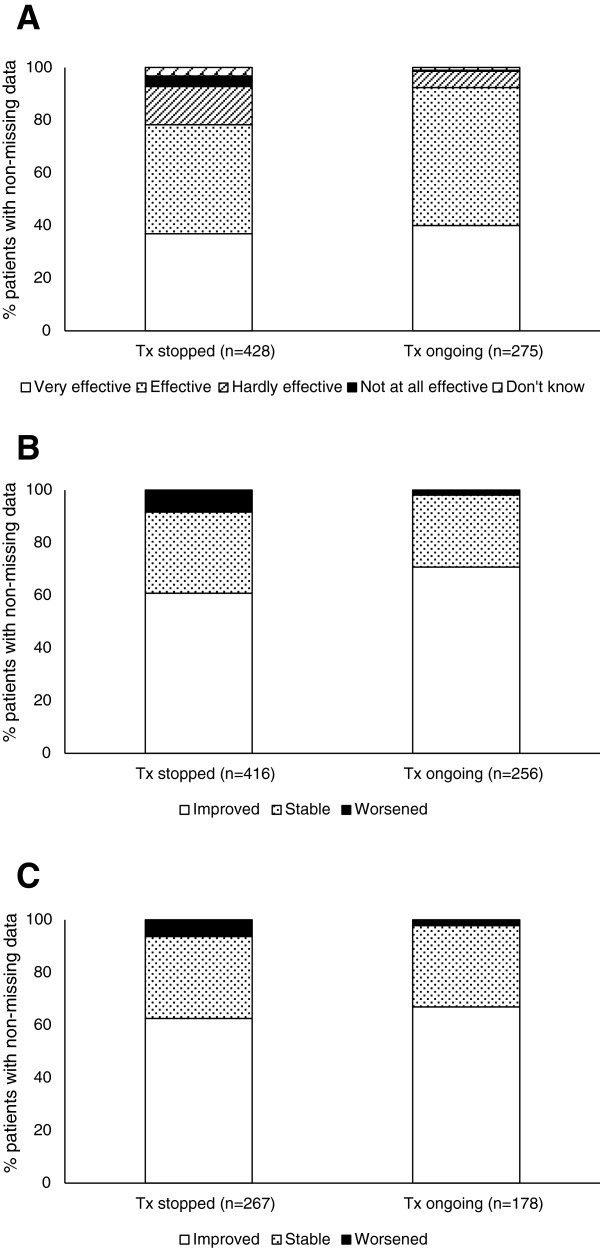
Physician-perceived efficacy of house dust mite SLIT at the last recorded visit. A. Physicians’ overall evaluation of SLIT / B. Symptoms of rhinitis / C. Symptoms of asthma.